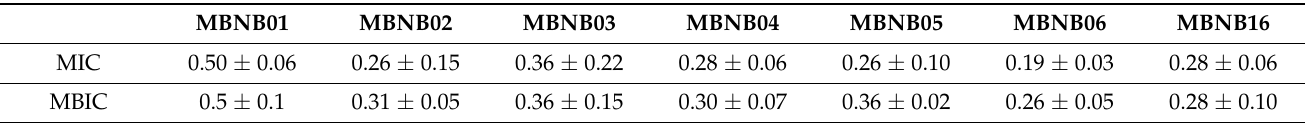
Table 4. Comparative average MIC and MBIC values in mg/mL for the different powders. For each powder, the values are averaged over all of the five tested microbial strains. Data are reported as mean ±